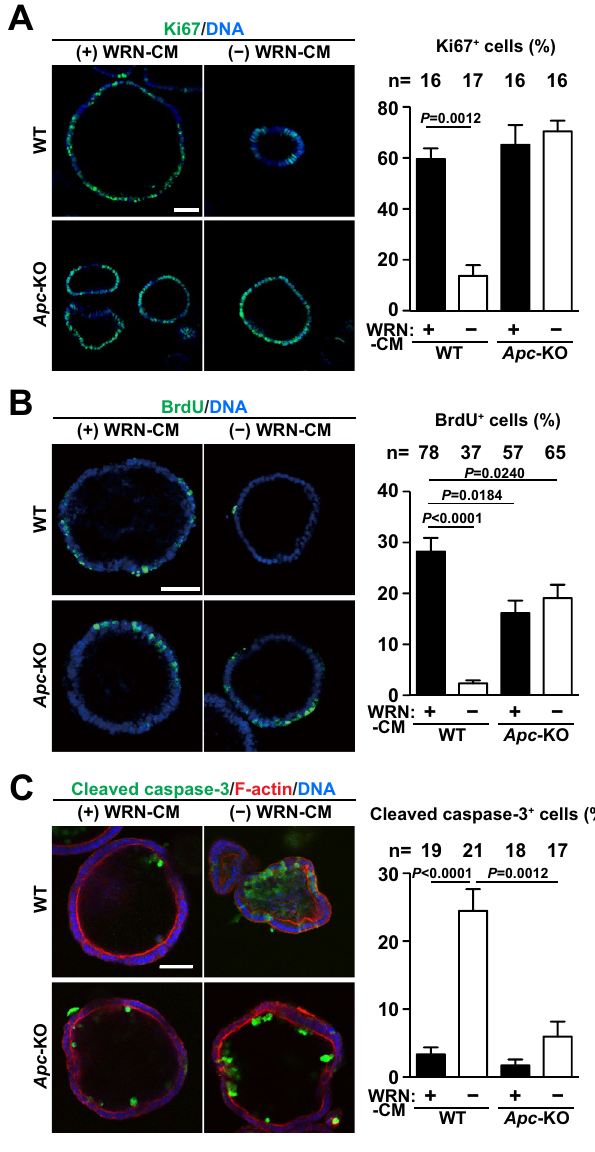
Figure 3. Cell proliferation and apoptosis in Apc -KO organoids. Organoids formed in the presence of WRN-CM were cultured in the presence or absence of WRN-CM for 3 more days. ( A , C ) The organoids were fixed and then stained using anti-Ki67 antibody ( A , green) and anti-cleaved Caspase-3 antibody ( C , green). Counter stain, DAPI for DNA (blue) and phalloidin for F-actin ( C , red). ( B ) After labeling with BrdU for 8 h, the organoids were fixed and stained with anti-BrdU antibody (green) and DAPI (blue). We counted the number of Ki67-positive ( A ), BrdU-positive ( B ), cleaved caspase-3-positive ( C ) and DAPI-positive ( A–C ) cells in the largest confocal section for each organoid. The ratio of the number of positive cells for each marker to that of the nuclei in the same section was quantified for each group. The total number of organoids analyzed is shown above each graph. Data are expressed as mean ± s.e.m. Dunn’s multiple comparison test was used after Kruskal–Wallis test to calculate P values. Scale bar, 50